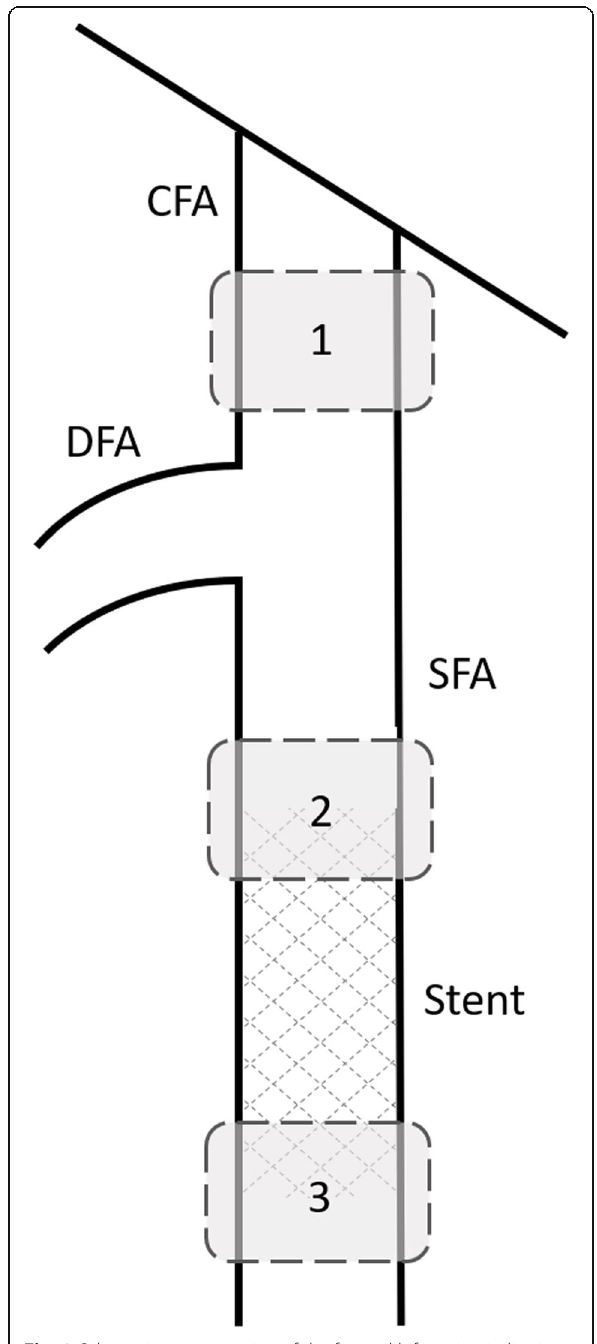
Fig. 2 Schematic representation of the femoral bifurcation indicating the locations of interest. High-frame-rate contrast-enhanced radiofrequency data was obtained at the common femoral artery (1), inflow region of the stent (2), and the outflow region of the stent (3). CFA Common femoral artery, DFA Deep femoral artery, SFA Superficial femoral